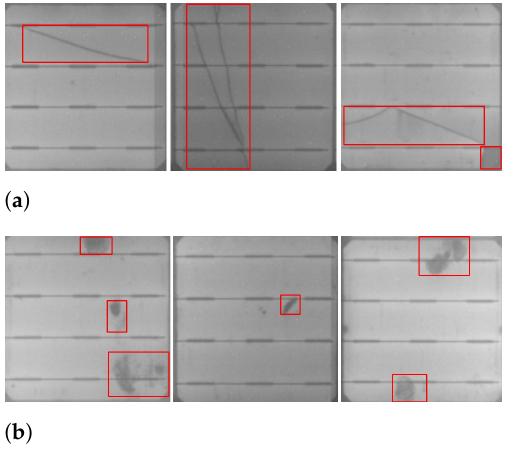
Figure 1. Samples of segmented solar cells containing defects: ( a ) cracks, ( b ) contamination